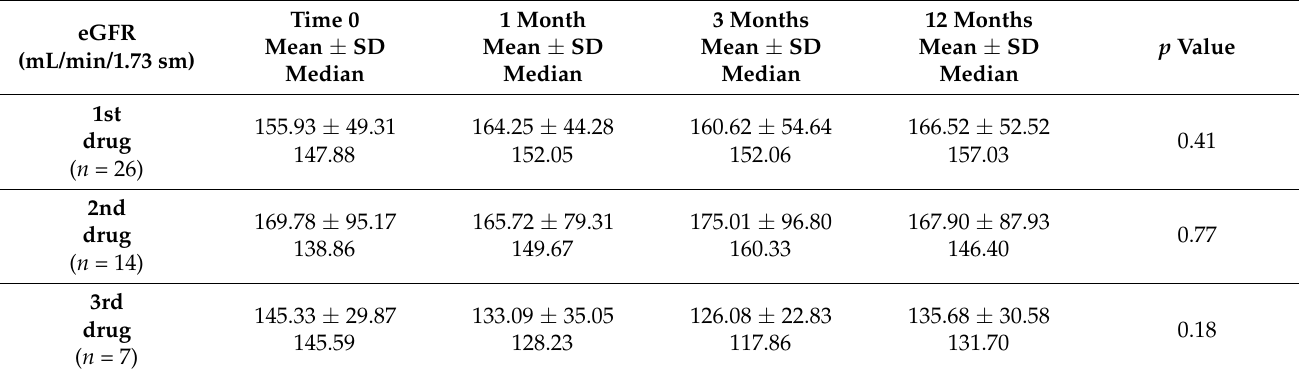
Table 3. Distribution of eGFR values at different time points from the introduction of the first, second, and third RAAS blocker. Most data were significantly right-skewed. All p values are from Repeated Measures Anova analysis of log- transformed data.